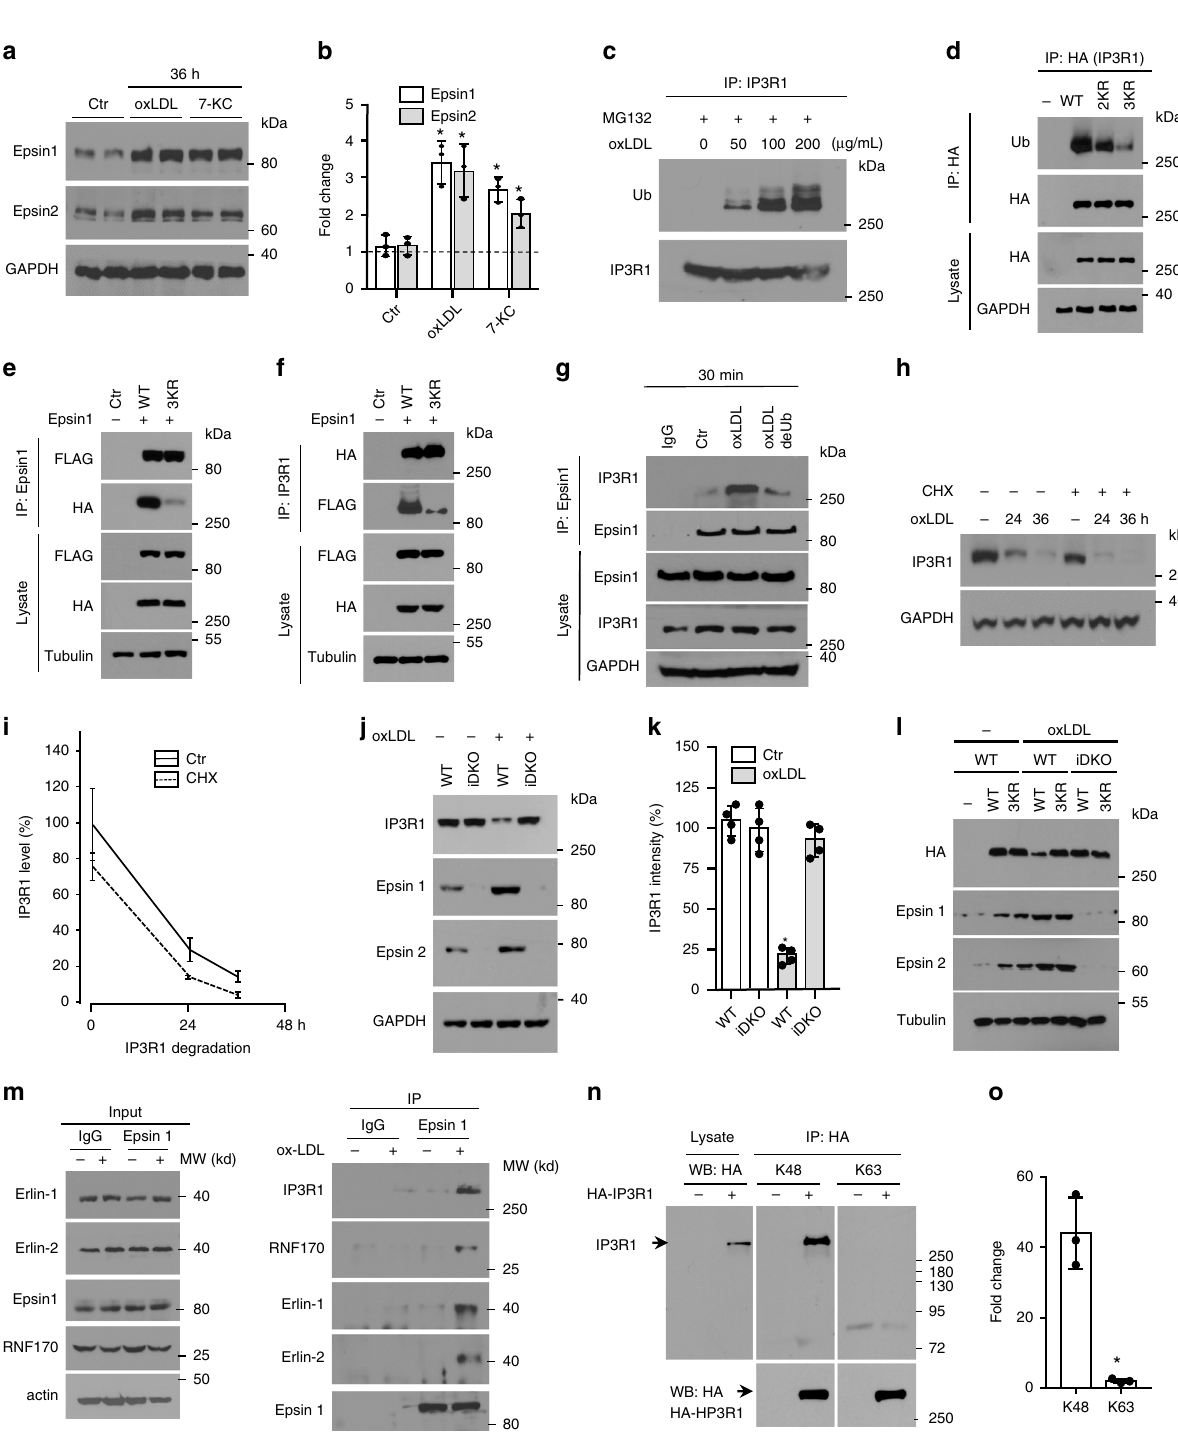
(Fig. 3e, f; Supplementary Fig. 7c, d). Second, we treated wild-type MAECs with 100 µg/mL oxLDL for 30 min and immunoprecipi- tated epsin 1 interacting proteins from lysates in the presence or absence of 10 µM USP2, which is a recombinant